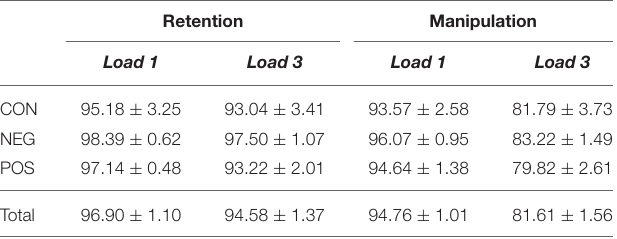
TABLE 2 | Mean accuracy with standard error across groups, conditions, and load. Retention